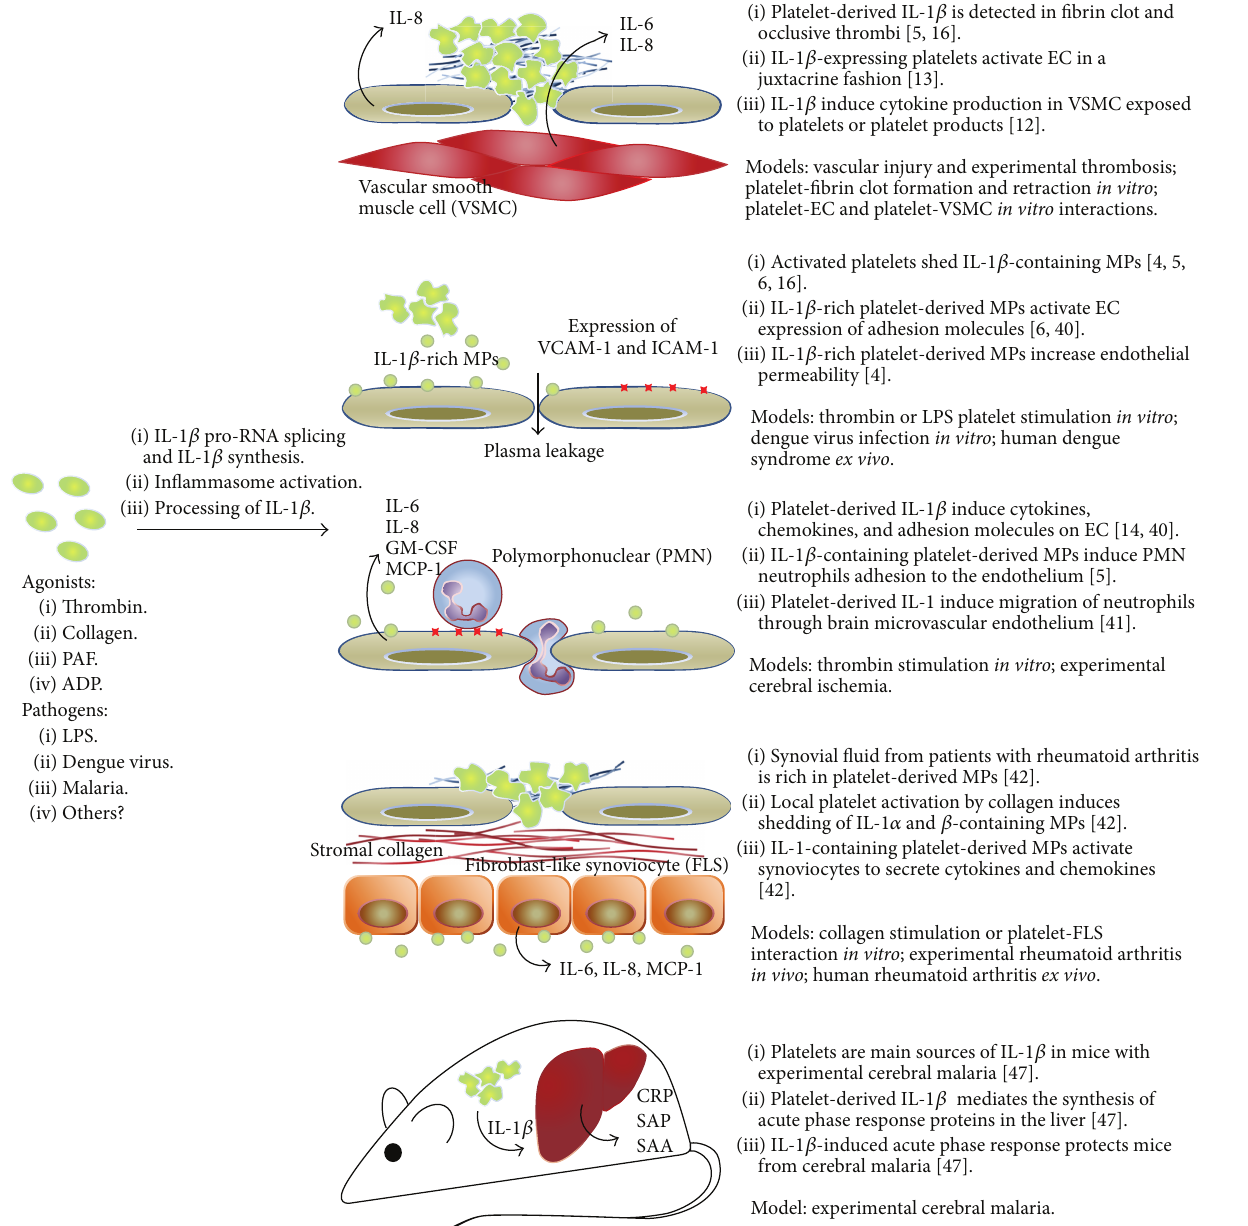
Figure 2: Overview of the consequences for platelet-derived IL-1 𝛽 and inflammasome activation in thromboembolic, infectious, and inflammatory diseases. EC: endothelial cell; MPs: microparticles; CRP: C reactive protein; SAP: serum amiloid P; SAA: serum amiloid